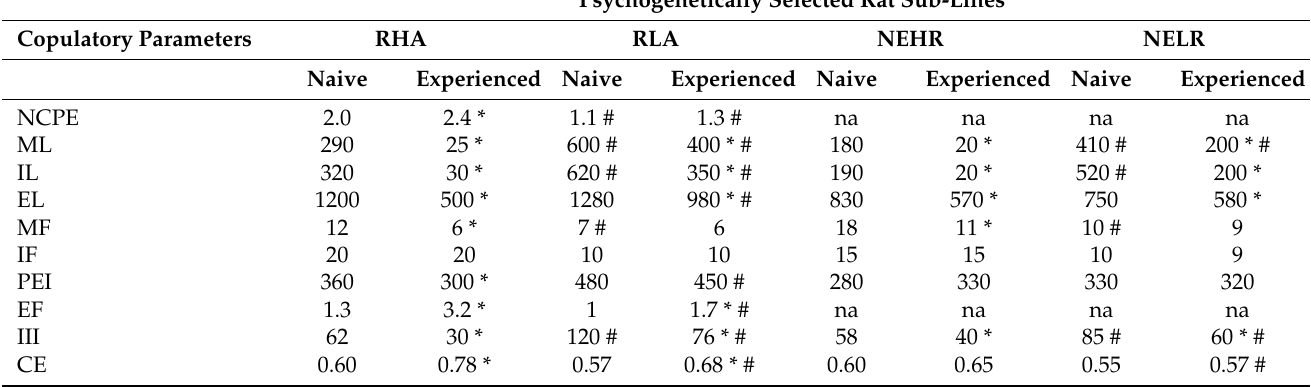
Table 11. Mean values of copulatory parameters measured in the first series of copulatory activity of male RHA/RLA, bNEHR/bNELR rat sub-lines at the first (sexually naïve condition) and at the fifth copulatory test (sexually experienced condition) with a sexually receptive female